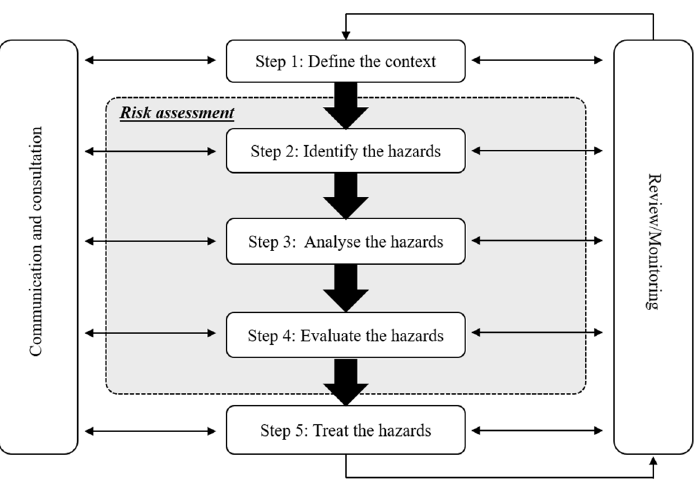
Figure 5. The procedure of typical hazard management.